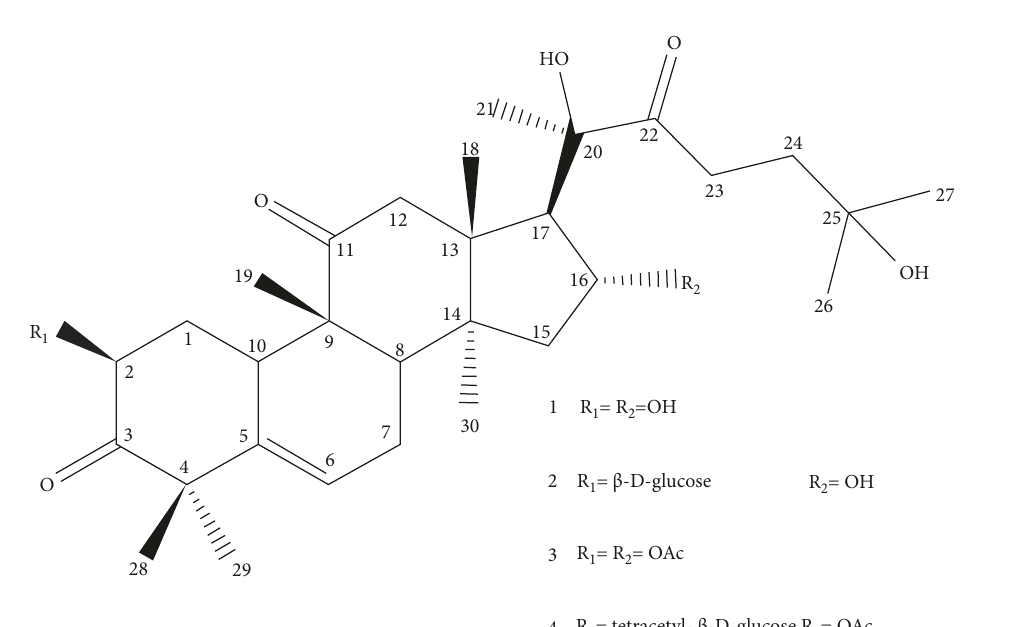
Figure 1: Chemical structures of 1-4 cucurbitane triterpenoids. 23,24-dihydrocyclyrbitacin D (1), 2-O- β glucopyranosyl 23,24-dihy- drocucurbitacin D (2), 2,16-diacetyl-23,24-dihydrocucurbitacin D (3), and 2-O- β (2 ′ ,3 ′ ,4 ′ ,6 ′ -tetraacetyl) glucopyranosyl-16-acetyl-23,24- dihydrocucurbitacin D